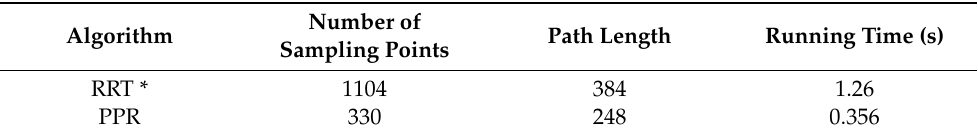
Table 1. Average values of the planning results obtained by the rapidly exploring random tree star (RRT *) algorithm and path planning algorithm based on prior path reuse (PPR).